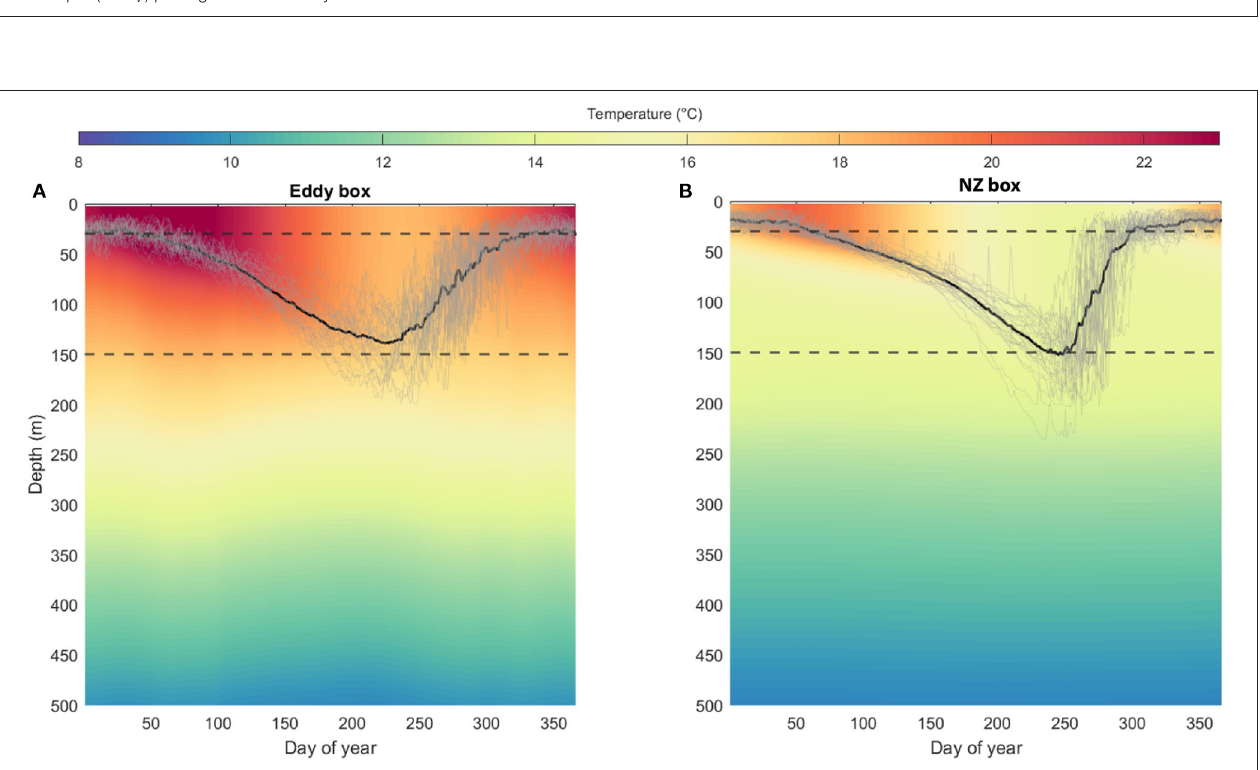
FIGURE 3 | Climatological temperature variability (colorbar) from the surface down to 500 m depth in the Eddy (A) and NZ boxes (B) . Mean SML depth is marked with solid black lines on each of the plots while the grey lines show annual SML depths for the 30 year period from 1985 to 2014.